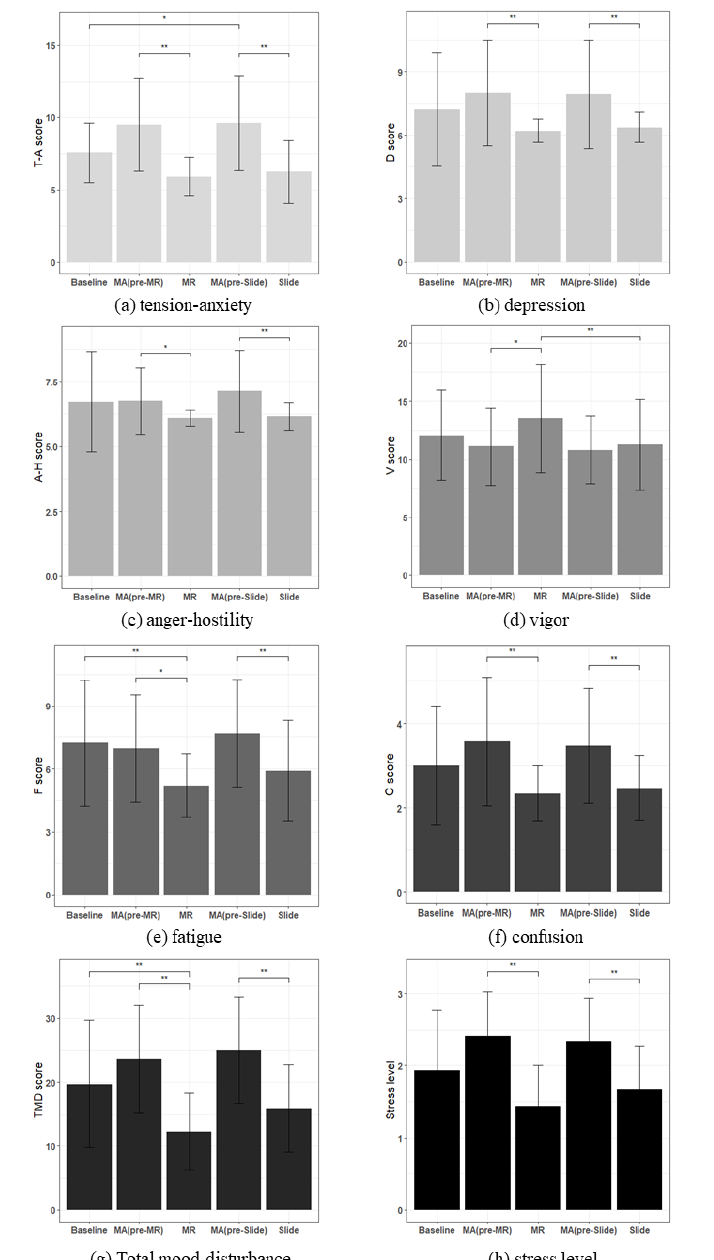
Figure 10. Comparison of survey result between average of baseline, MA (pre-MR), MR, MA (pre- slide), and Slide. N = 30, mean ± standard error; *: p < 0.05; **: p < 0.01; significant differences